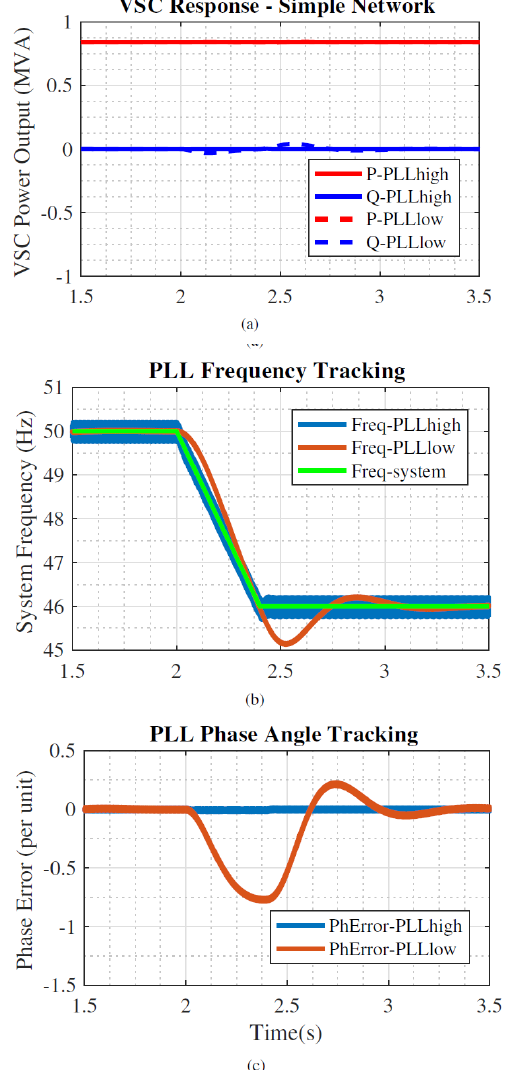
Figure 8. Simulation results with a simplified network and different PLL parameters (see Table 1)—( a ) VSC output ( b ) PLL frequency tracking ( c ) PLL phase angle